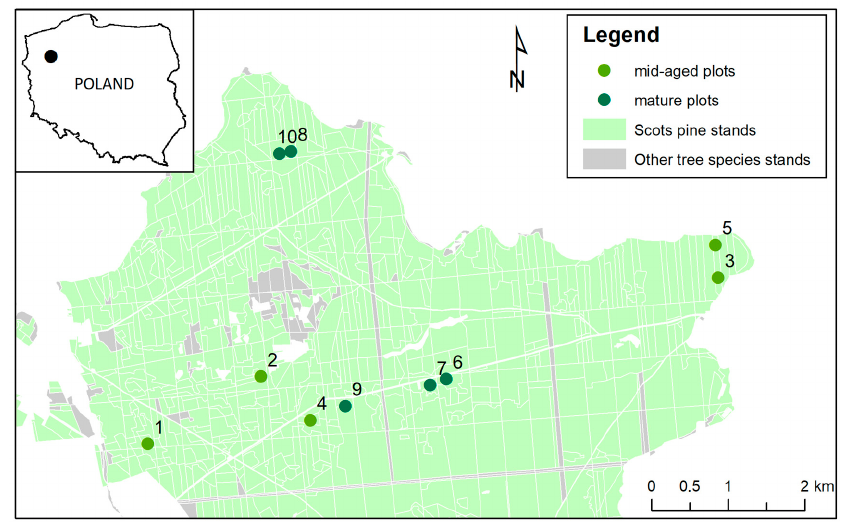
Figure 1. Distribution of sample plots in mid-aged and mature Scots pine stands in northwestern Poland.